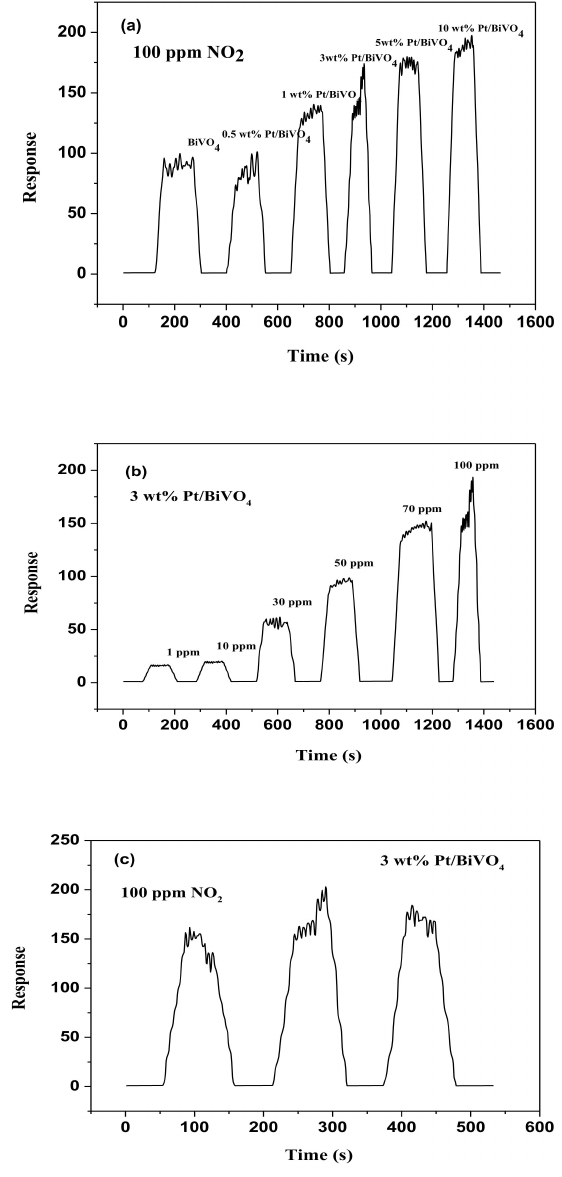
Figure 5. ( a ) The response for varying Pt/BiVO 4 nanocomposites contents of 100 ppm nitrogen dioxide at room temperature; ( b ) Curves for responses of the 3wt.% Pt/BiVO 4 in the range of 1–100 ppm nitrogen dioxide at room temperature; ( c ) Three-cycle repeated response curves of the 3wt.% Pt/BiVO 4 to 100 ppm nitrogen dioxide at room